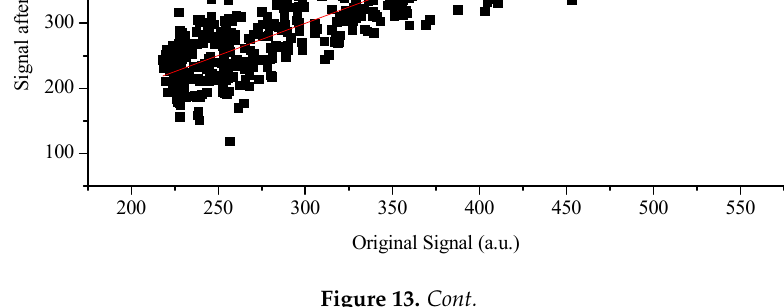
Original Signal (a.u.) Figure 13.